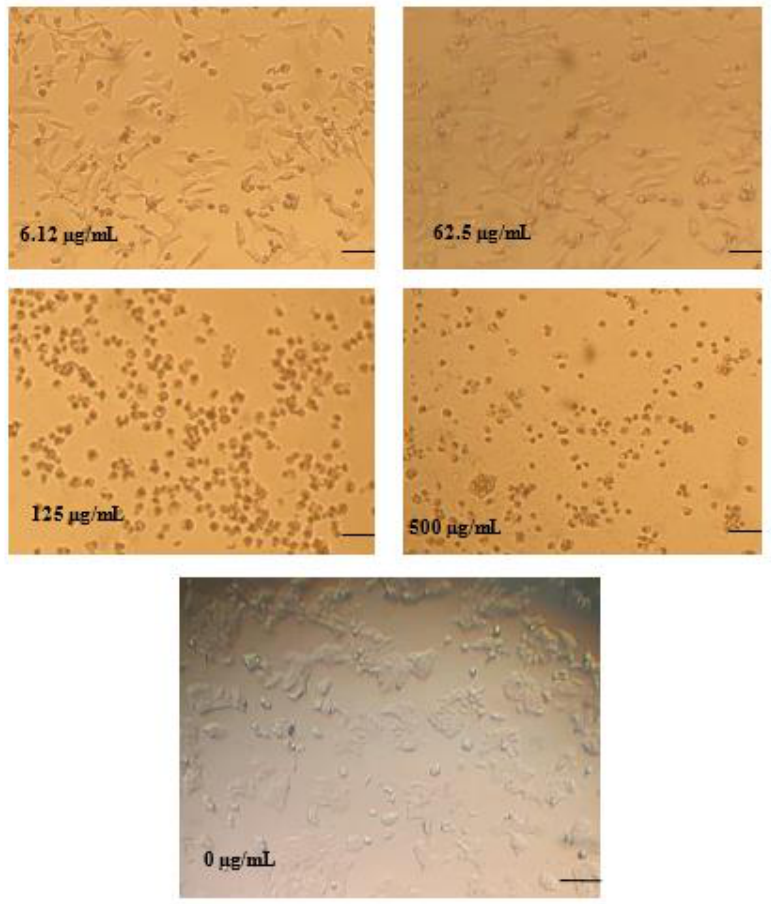
Figure 4. Photograph of cancer cell lines after being treated with B. hispanica extracts. ( × 10; scale bar = 0.5 cm).